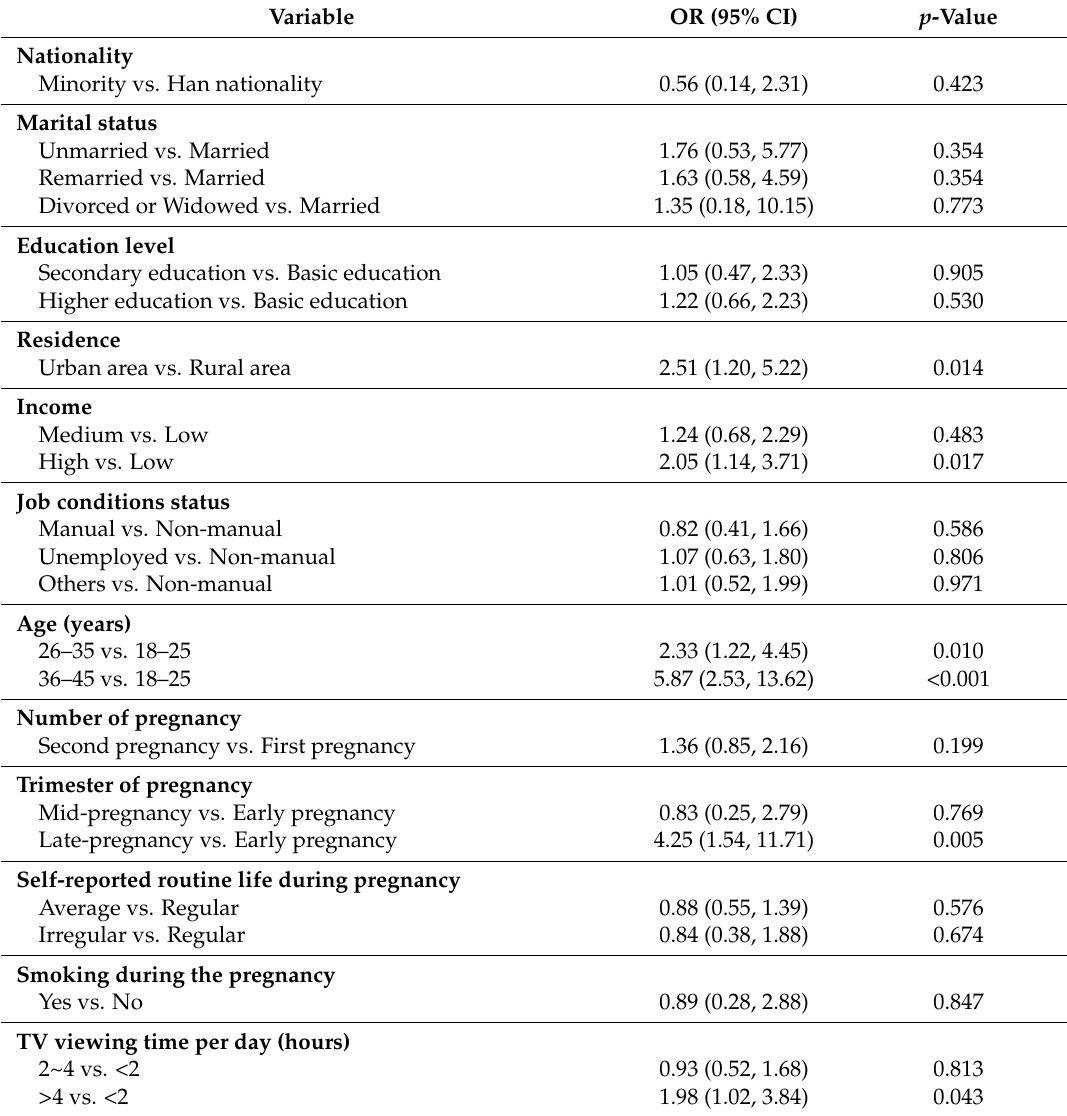
Table 2. Univariate logistic regression analysis for factors that affect gestational diabetes mellitus, China. Variable OR (95% CI) p